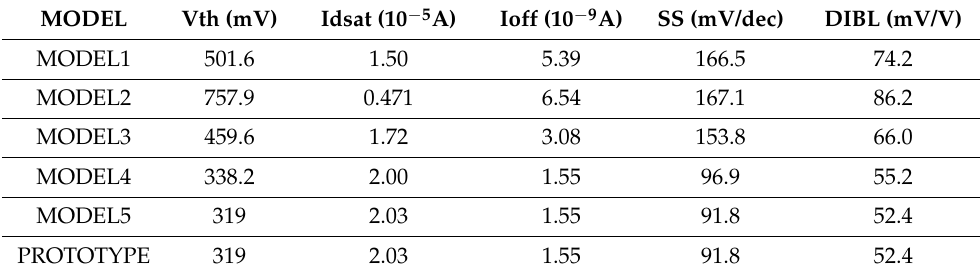
Table 1. A comparison of the electrical parameters in the different